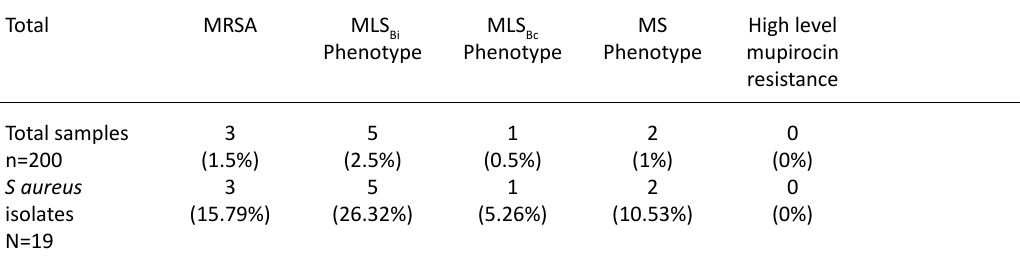
Table 2. Resistance pattern of Staphylococcus aureus isolates Total MRSA MLS